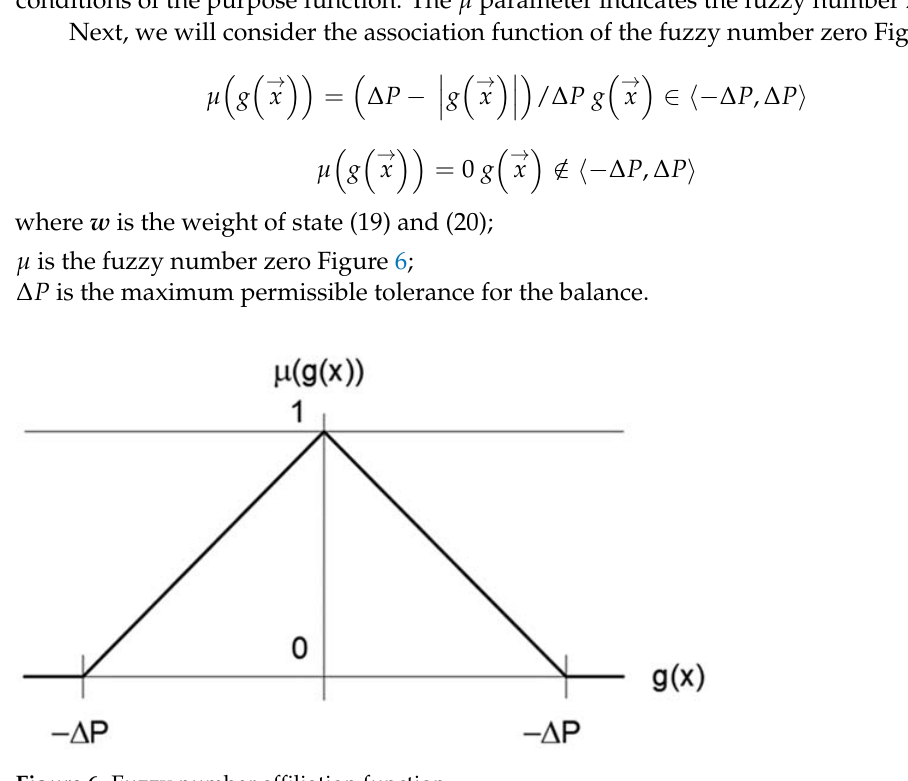
Figure 6. Fuzzy number affiliation